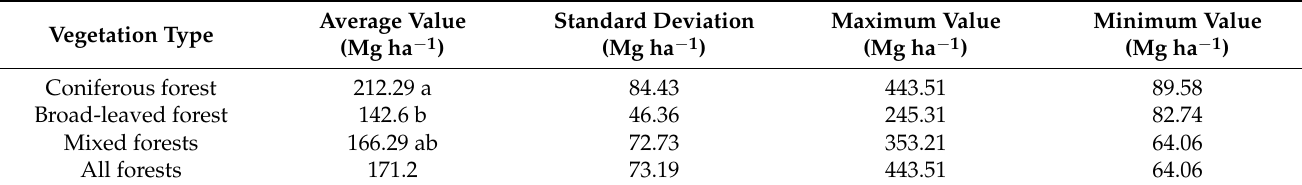
Table 1. Statistics of aboveground vegetation water storage (AVWS) of different forest types in 54 sample